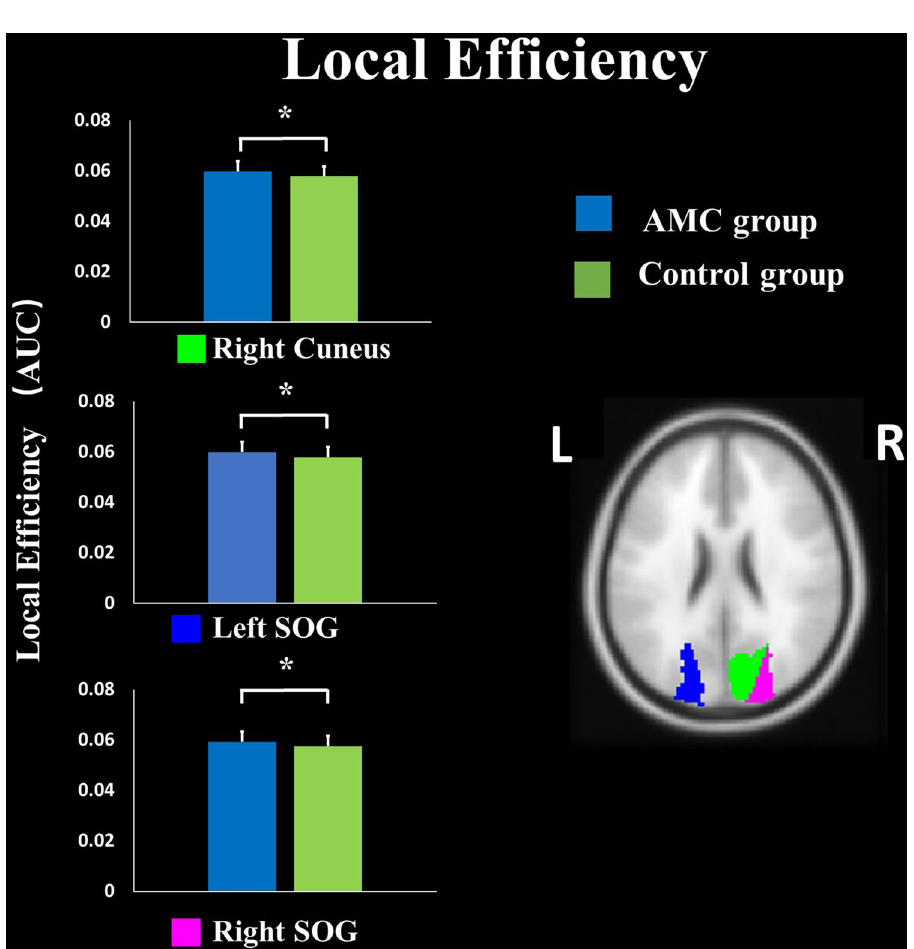
Figure 3. Group differences in local efficiency in bilateral SOG (superior occipital gyrus) and right cuneus. * p corrected < 0.05. L: left, R: